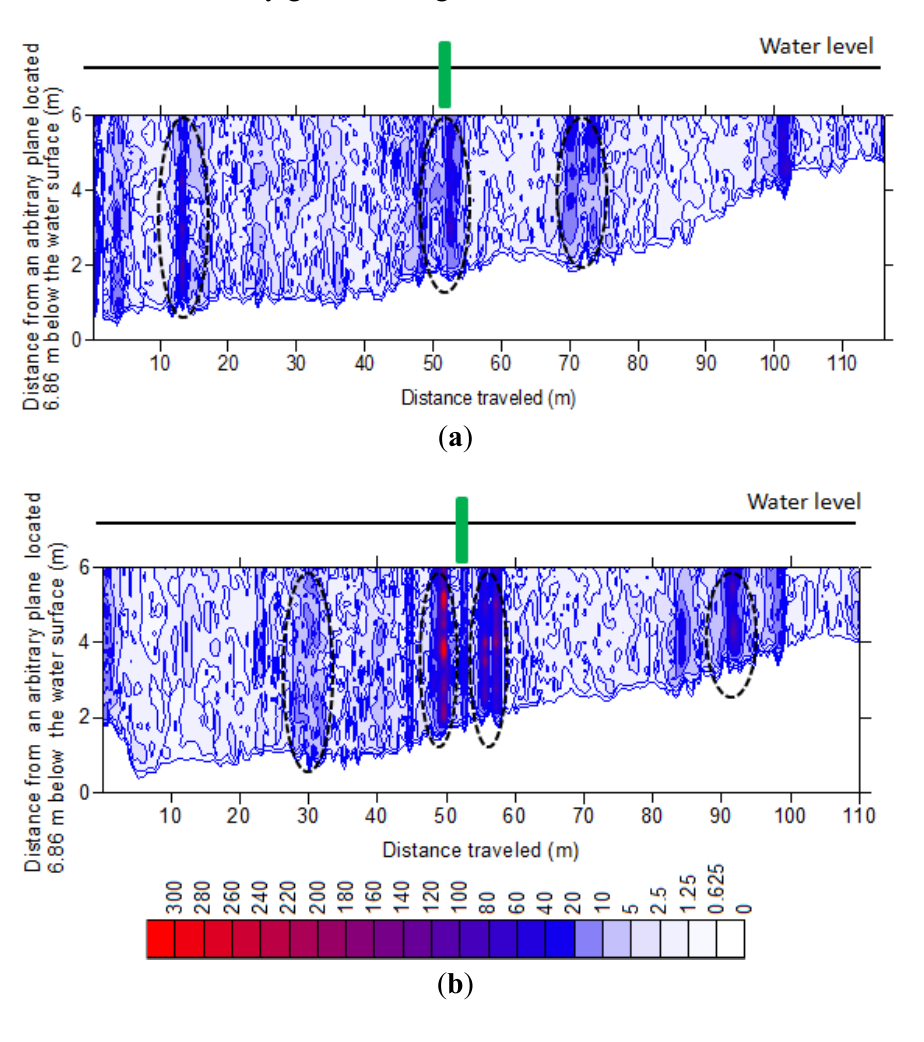
( a ) DDD minimum opening; ( b ) buoy only. Dashed lines describe zones of high vorticity values. The scale is given in 1/s. Flow is going into the page. Projected DDD apex and buoy locations are indicated by green